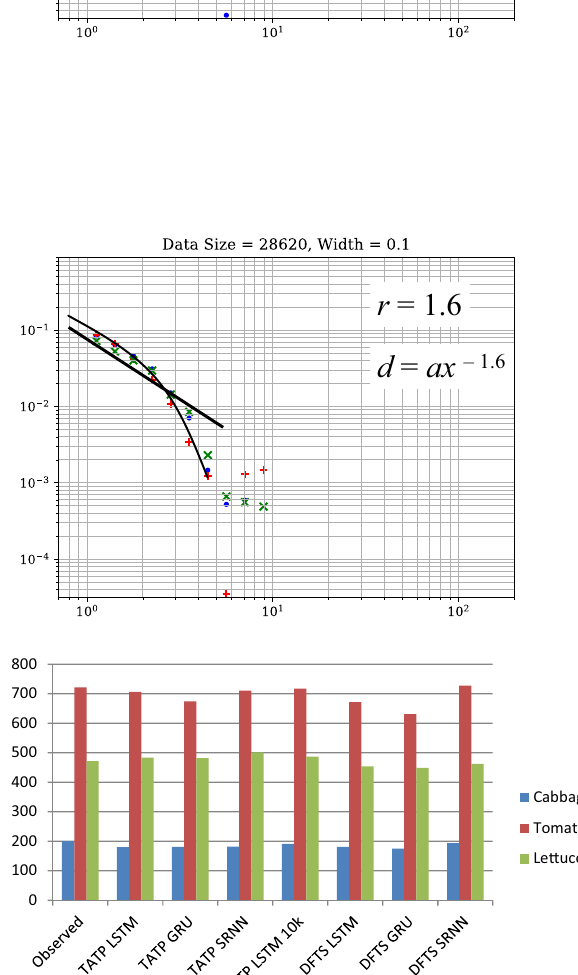
Fig. 14 Trends by seasonal decomposition when cycle is 53